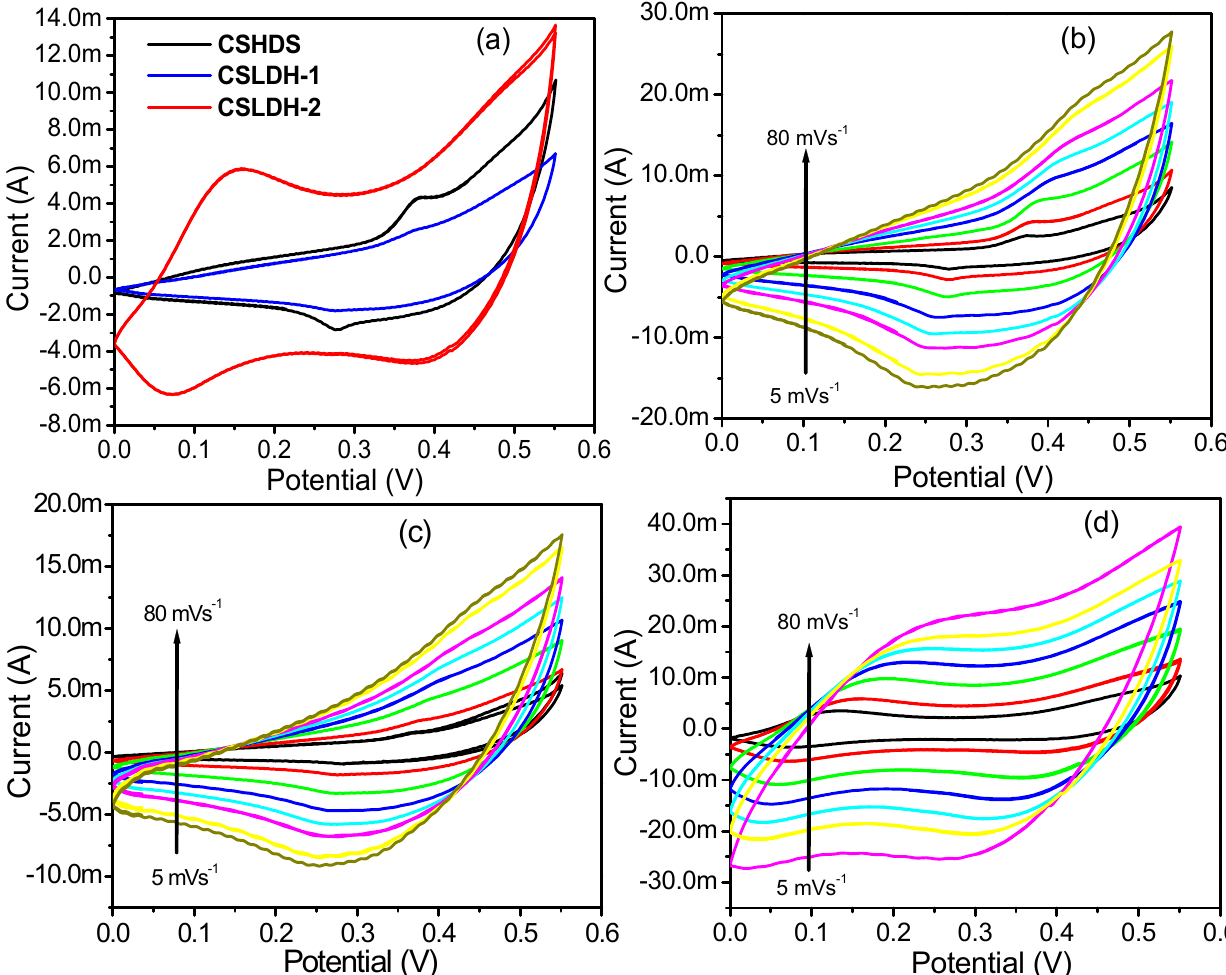
Figure 11. ( a ) Comparative CV curves of CSHDS, CSLDH-1 and CSLDH-2 at fix scan rate of 10 mVs − 1 ; ( b ) CV curves of CSHDS; ( c ) CSLDH-1; and ( d ) CSLDH-2 at different scan rate.